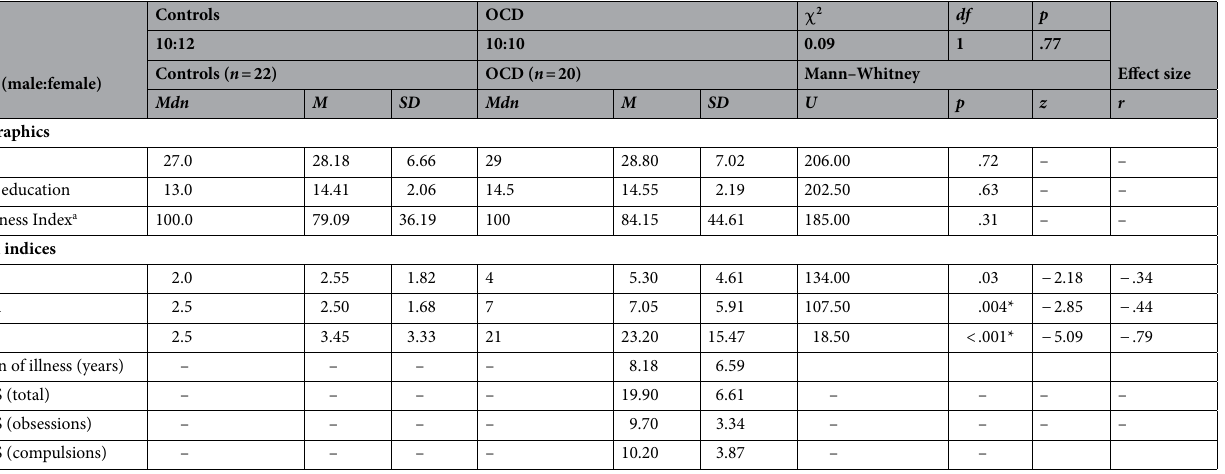
Table 1. Descriptives of demographics and clinical indices. a Handedness index is measured using